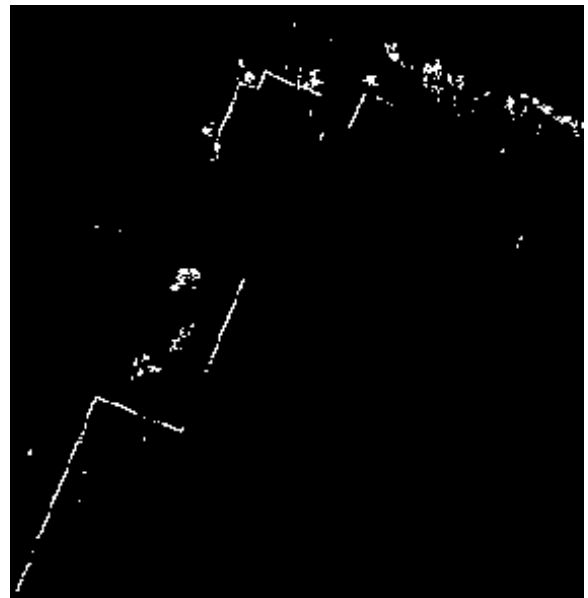
Figure 1. Cross section image of first point cloud